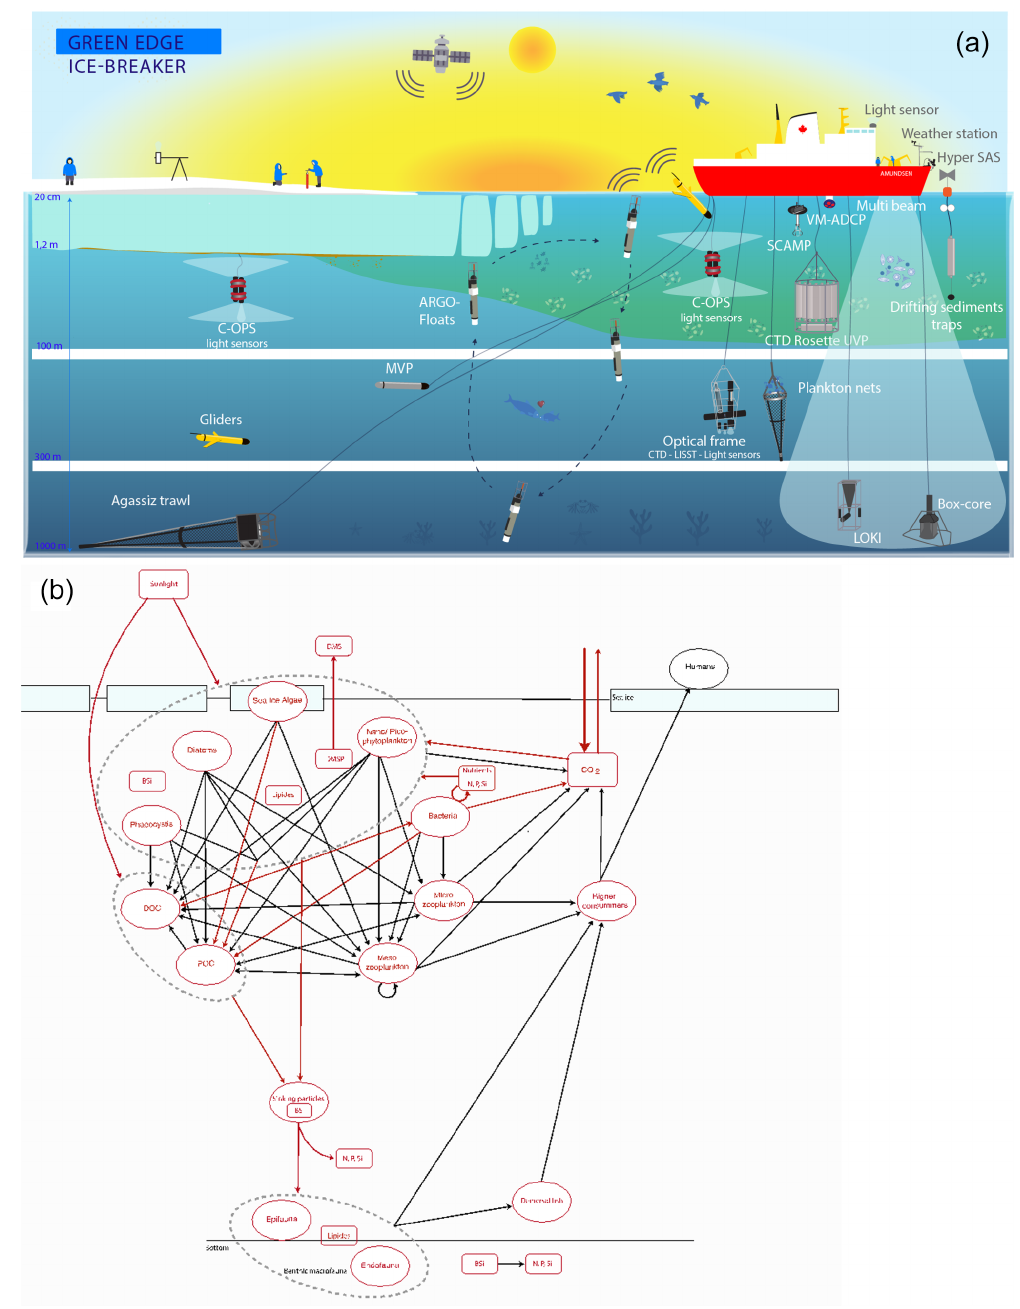
Figure 4. (a) Representation of all operations carried out during the Green Edge campaign. (b) Schematic representation of all stocks (bubbles) and fluxes (arrows) measured during the Green Edge cruise as part of the MIZ trophic system. Measured and calculated variables are represented in